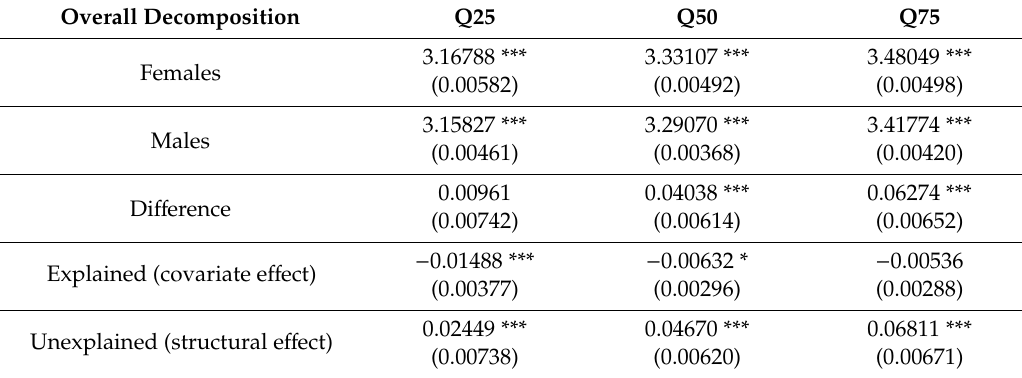
Table 3. Recentered influence function decomposition of BMI distributional di ff erence. Results from the 2013 Saudi Health Interview Survey